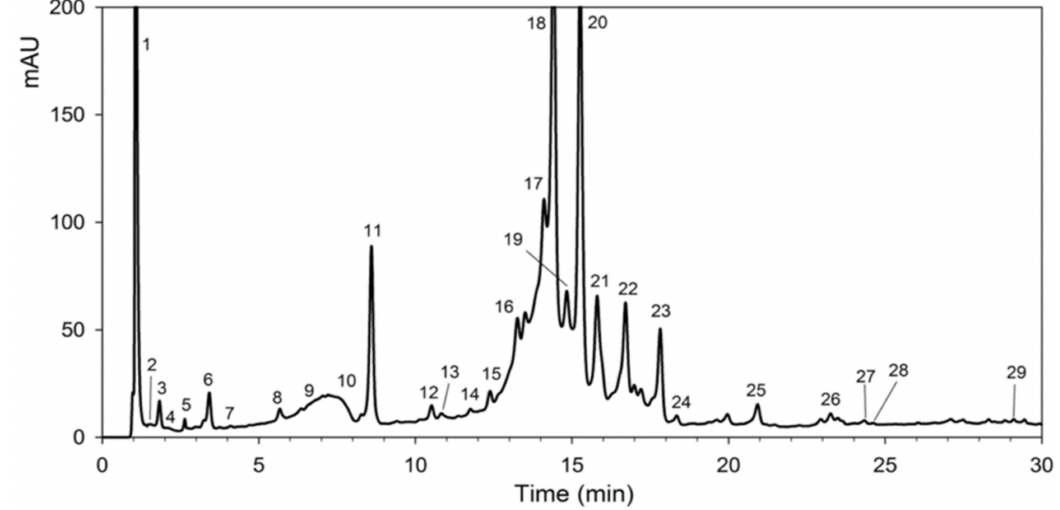
Figure 1. Chromatogram and identified compounds of the crude leaf extract obtained from